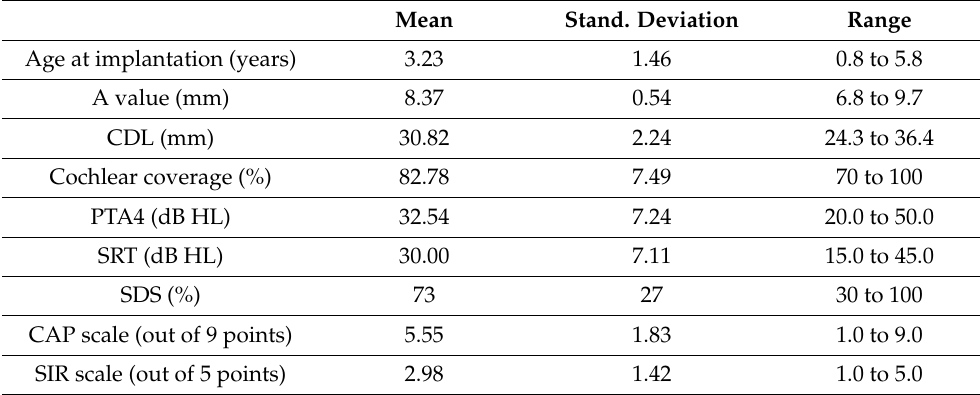
Table 1. Demographic characteristics of the participants. Their A-values, CDL, cochlear coverage, pure tone thresholds, SRT, SDS, CAP, and SIR, were also listed. Mean Stand.